Question: From the figure, is the trend upward or downward?
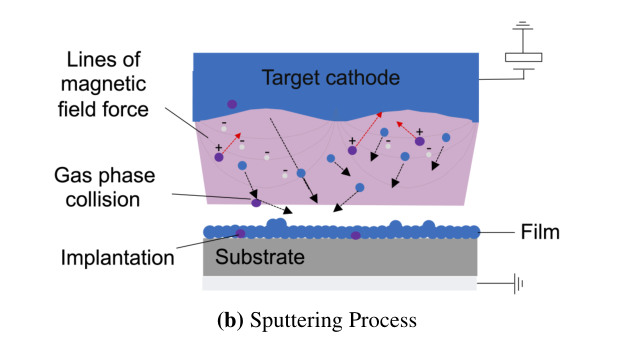
Answer: increasing